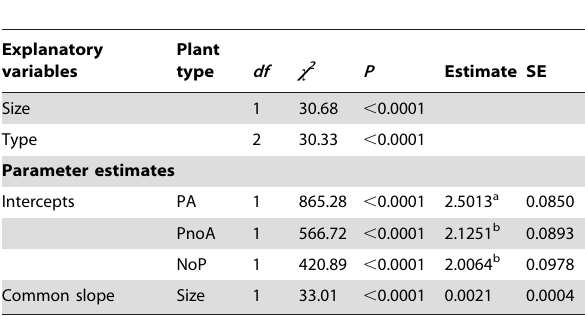
Table 3. Results of the Poisson regression model testing for the effect of plant size, plant type (PA, PnoA and NoP) and their interaction on the number of functional